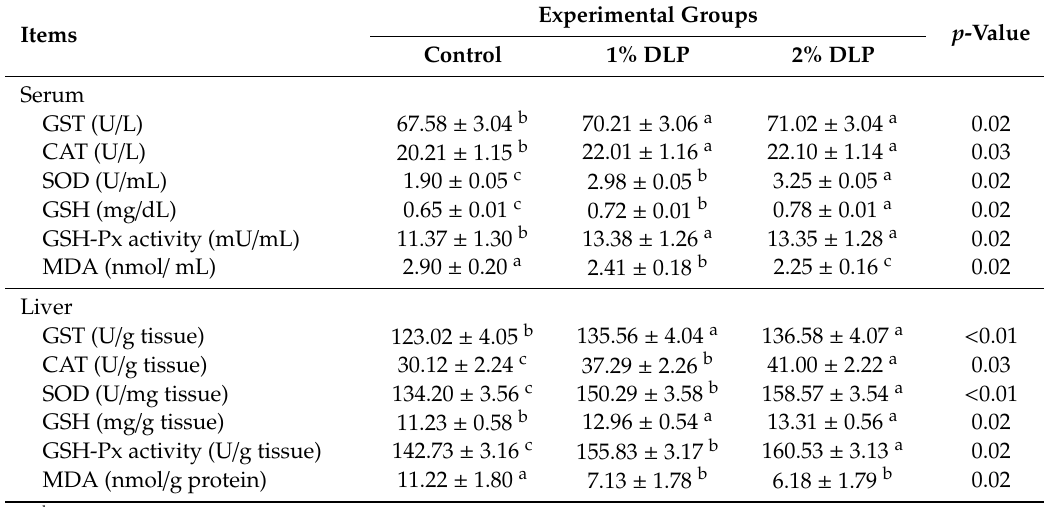
Table 8. E ff ects of dried lemon diet on serum and hepatic oxidative stress biomarkers of growing